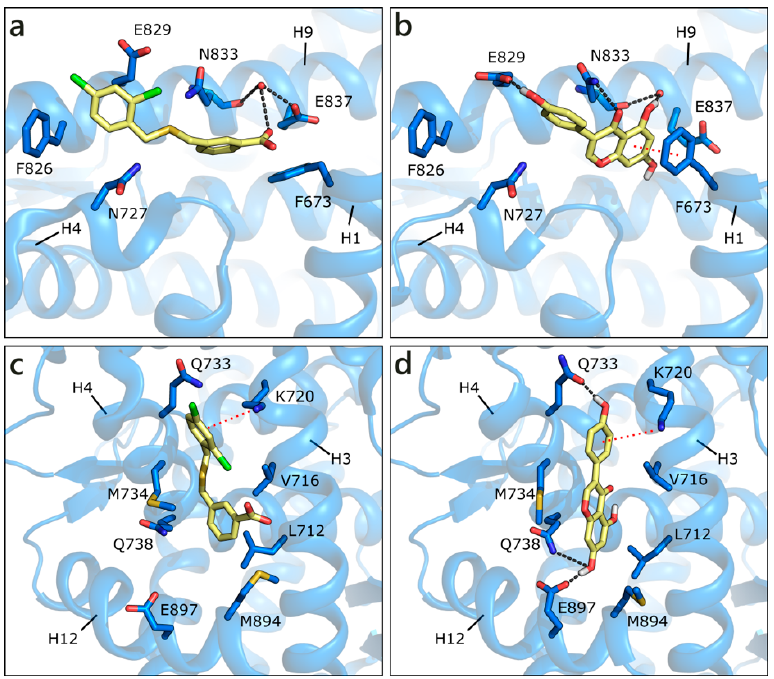
Figure 5. Crystallographic pose of the co-crystallized ligand ( a ), and docking pose of GEN ( b ) in the BF3 pocket of wild type AR (PDB ID 2ylp [68]). Crystallographic pose of the same co-crystallized ligand ( c ), and docking pose of GEN ( d ) in the AF2 pocket of wild type AR (PDB ID 2ylp [68]). The protein is shown in transparent blue cartoon, the residues lining the binding site and the ligands are shown in capped sticks and colored blue and yellow, respectively. Helices and residues lining the pocket are labelled, hydrogen bonds are displayed as black dashed lines. Water molecules are represented as red spheres.